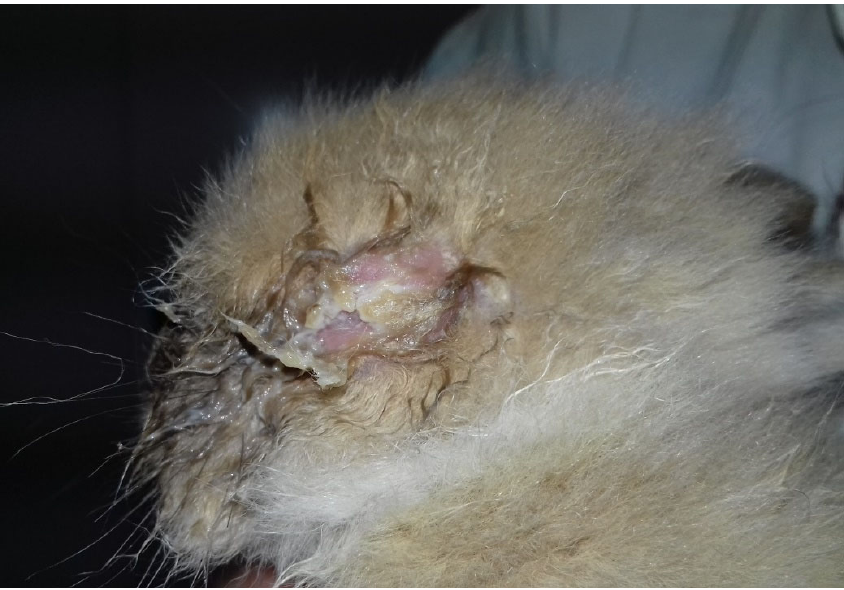
Figure 2. Left side of the head of a bunny with severe conjunctivitis. Note the purulent ocular discharge that occludes the eyelid.